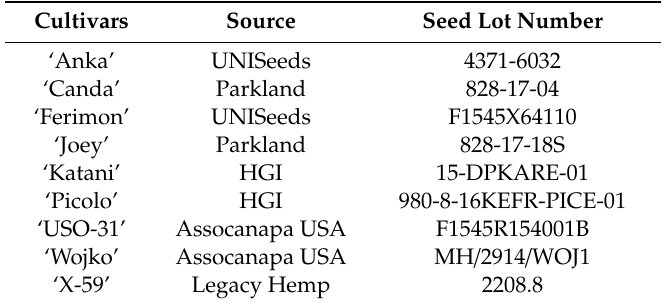
Table 1. Nine hemp cultivars used in this study with their sources and seed lot number.